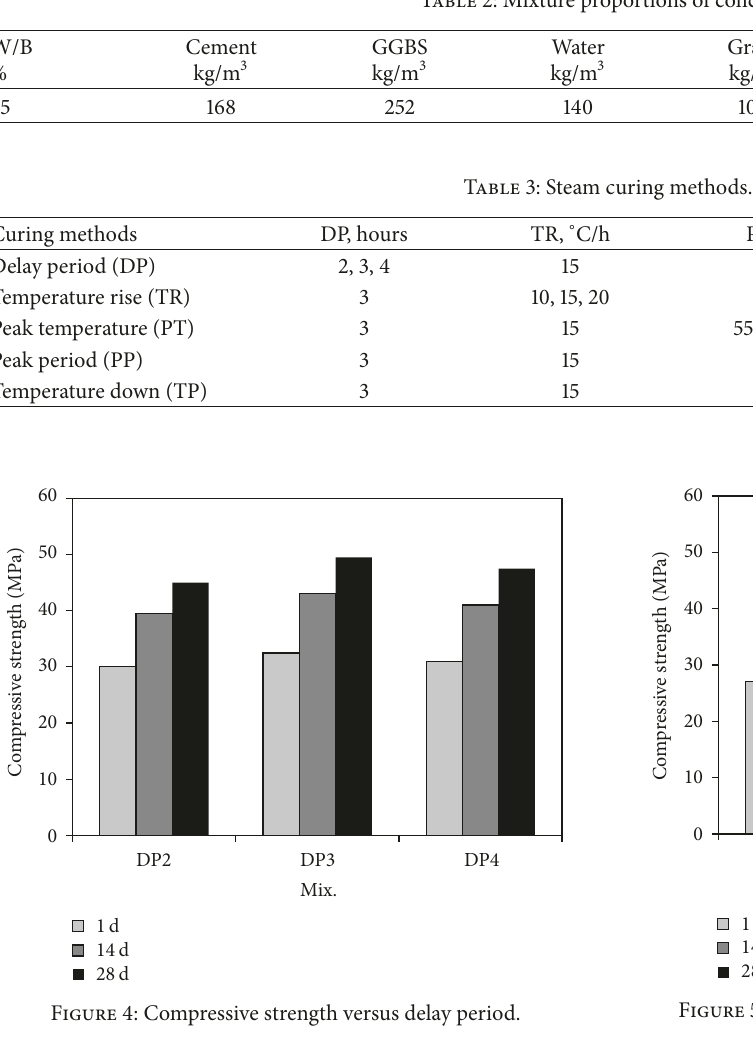
Table 2: Mixture proportions of concrete.